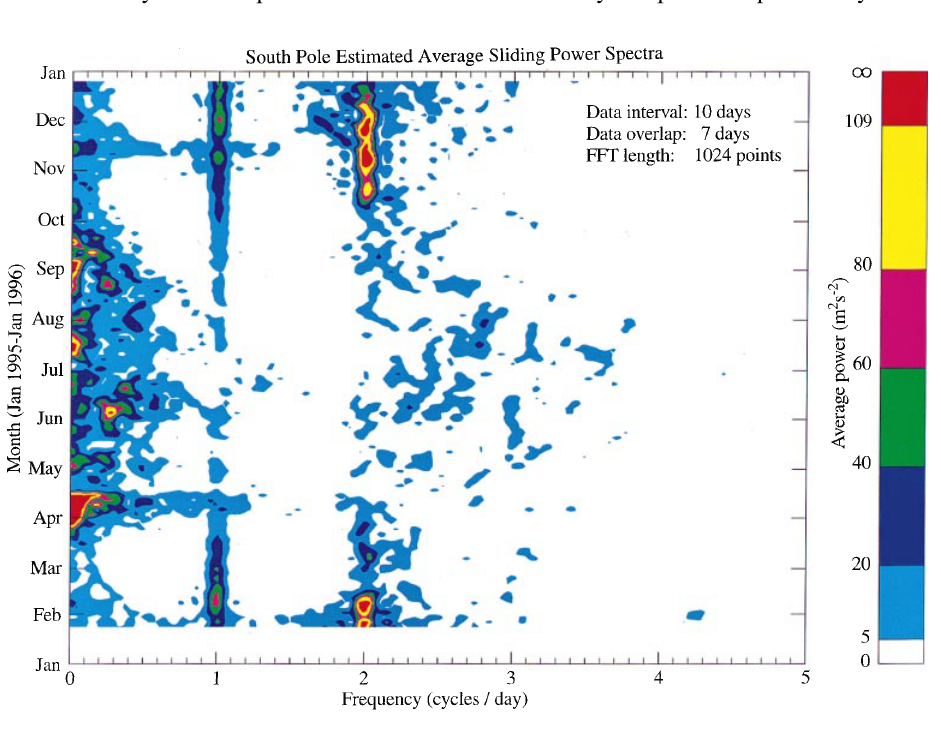
Fig. 1. Average spectrogram of the hourly meridional winds over the four directions of measure- ment. The spectrogram is formed by sliding 10-day spectra in in- crements of 3 days from